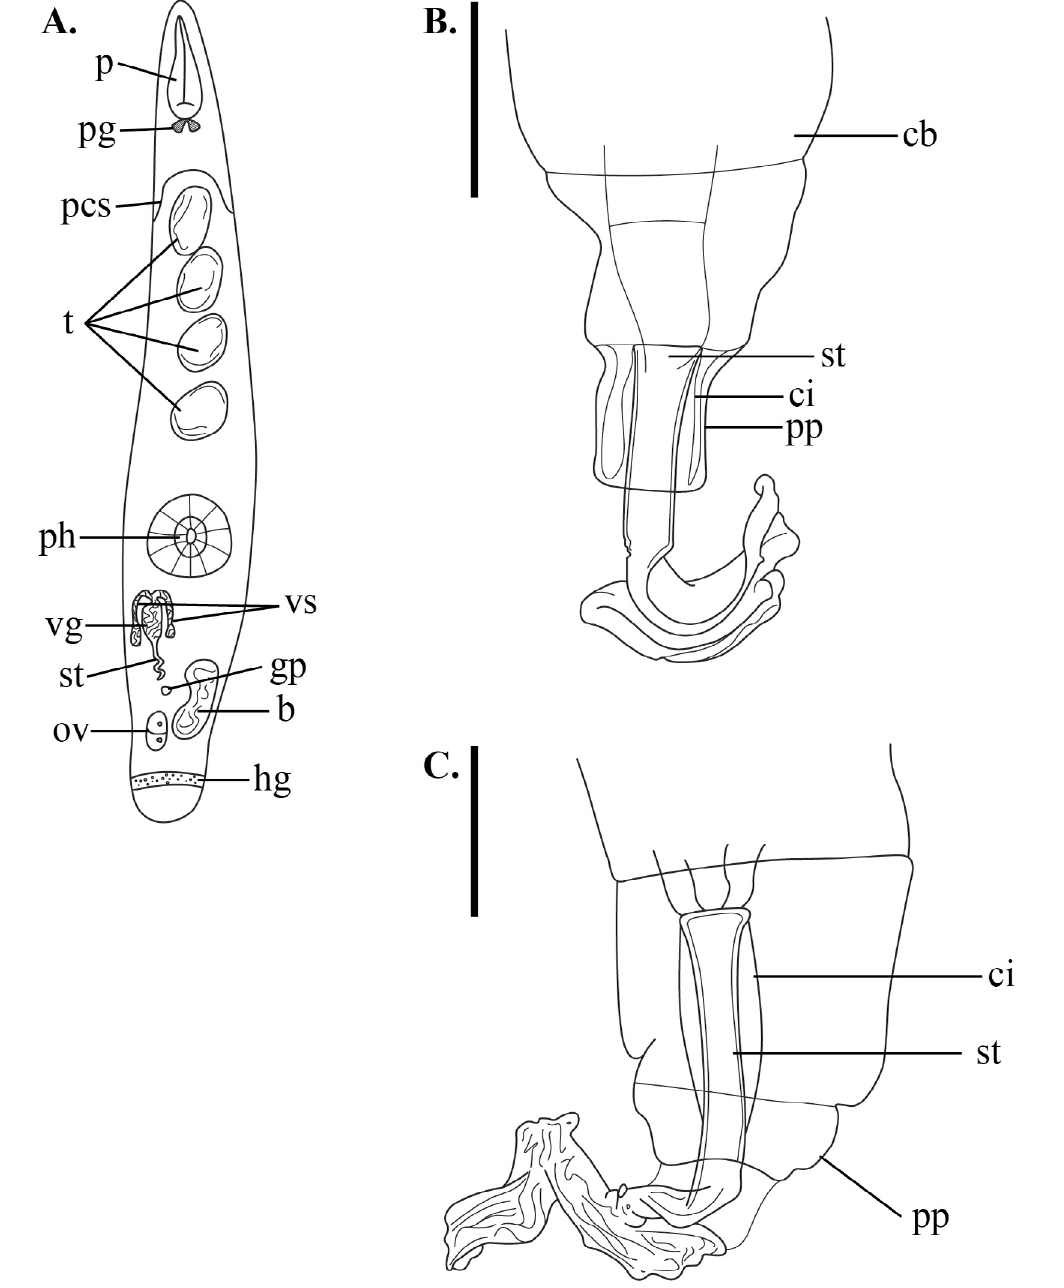
Fig. 1. Schizochilus coninxae sp. nov. A . Habitus of live specimen collected at the type locality. B–C . Distal end of the copulatory bulb, with stylet and penis papilla. B . Holotype (HU 614). C . A specimen from the reference collection of Hasselt University (HU X.1.32). Scale bars: 20